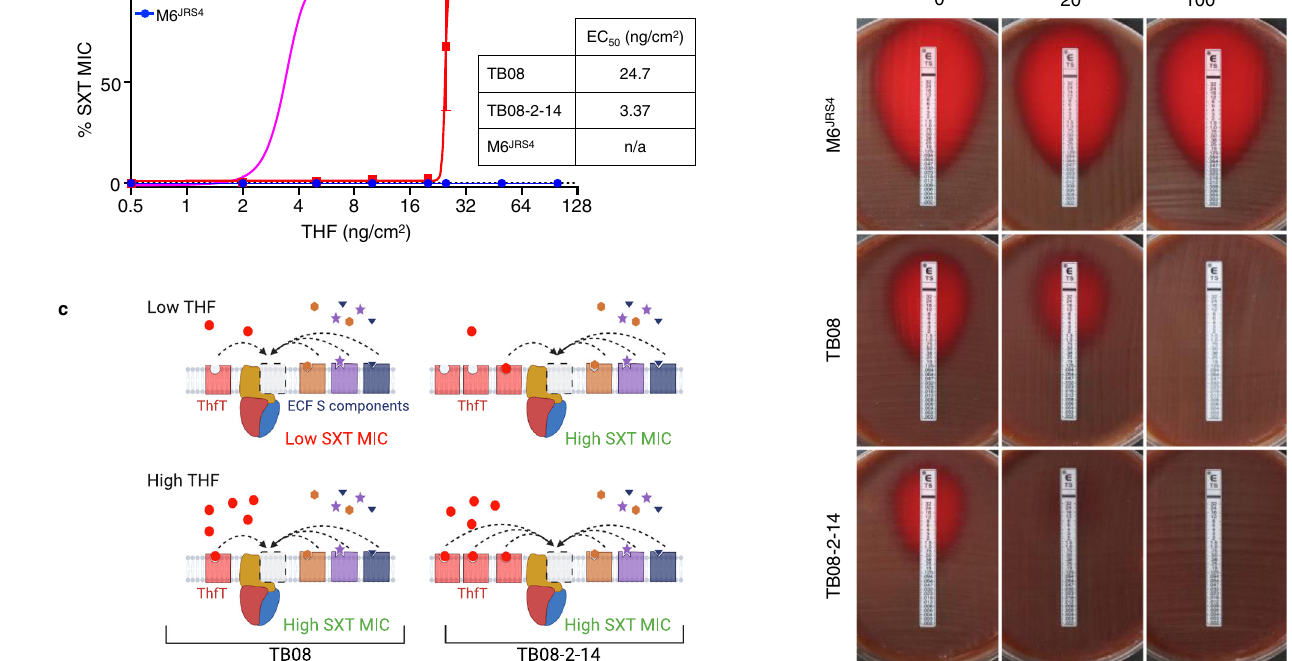
competition with other ECF S components for ECF transport modules and the effect on SXT MICs. Under conditions of low ThfT expression and low exogenous THF, competition between THF-loaded ThfT and S components loaded with other compounds limits THF import, resulting in low SXT MICs (top left). This compe- tition is overcome by increased ThfT expression (top right) or increased extra- cellularTHF,whichresultsinhighSXTMICs.Sourcedataforpanel a isprovidedasa Source Data fi